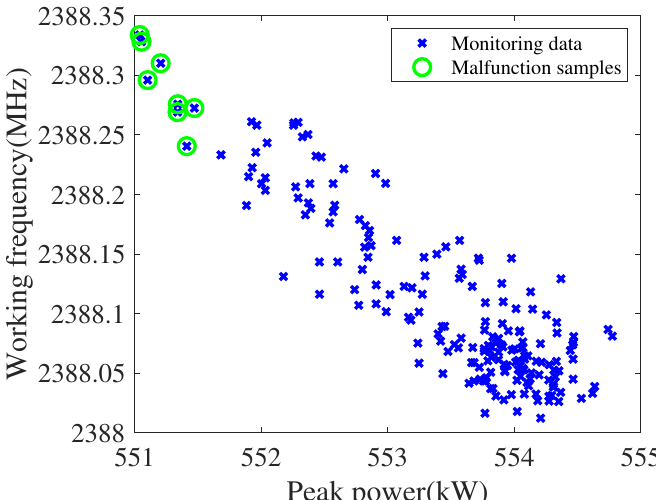
Figure 9. The visualization results of the degradation malfunction prognosis experiment without prediction by DU-ARIMA.